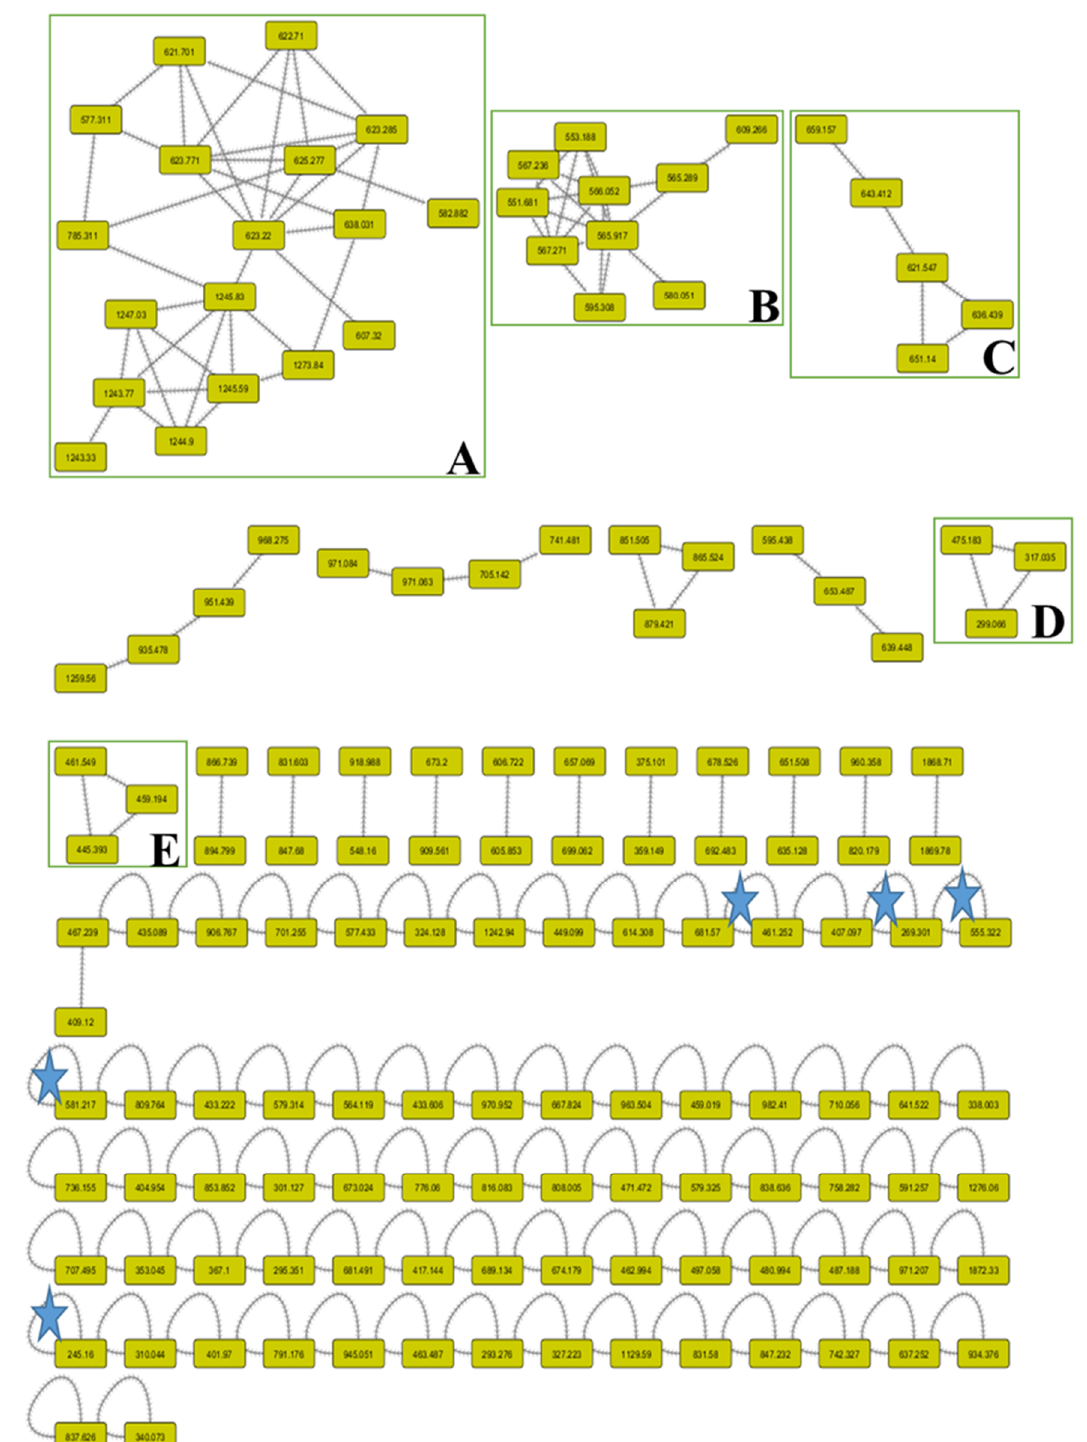
Figure 2. Complete molecular networking (MNW) generated using MS/MS data in (–ve) negative mode from L. coronopifolia aerial parts’ extract. Nodes are labeled with parent mass.